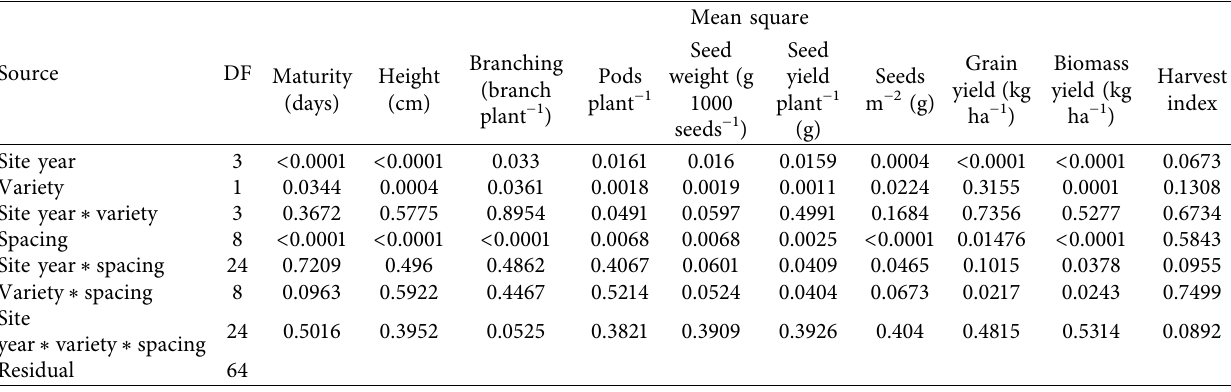
Table 3: P value from the analysis of variance for the effect of site year, variety, and spacing on phenology, growth, yield, and yield components of chickpea, replications, and their interactions with fixed effects considered as random effects.